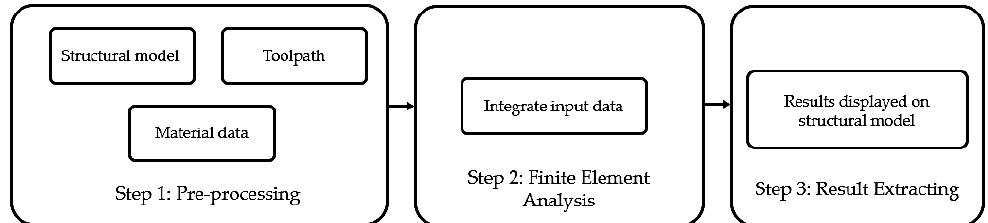
Figure 2. FEA workflow for macroscale modelling.